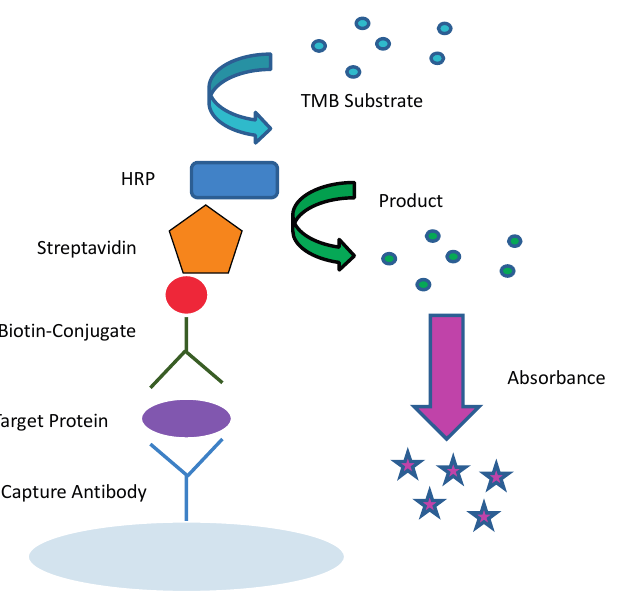
Figure 3. ELISA detection scheme using the enzyme horseradish peroxidase